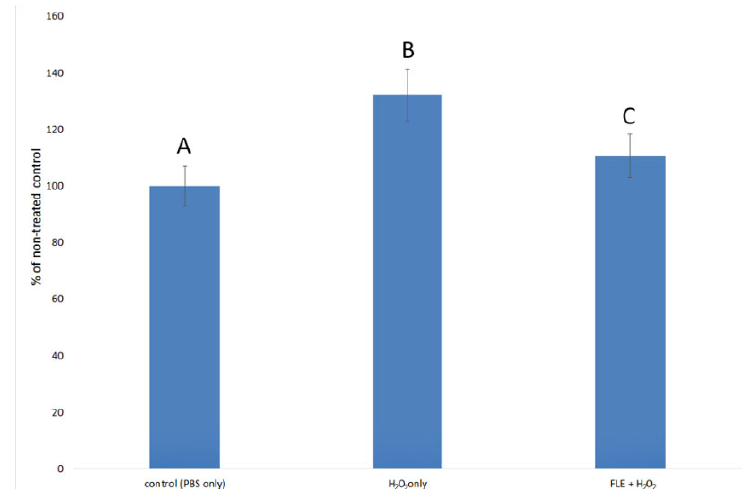
Figure 5. The expression of caspase-3, an early/moderate apoptosis marker, in HFFF-2 fibroblasts induced by hydrogen peroxide is shown as a percentage of control values (PBS only). H 2 O 2 only—cells treated with H 2 O 2 without the use of an extract; FLE + H 2 O 2 —cells incubated with 100 µ g/mL F. limosus extract and 500 μ M hydrogen peroxide. Different letters mean that the values for the bars differ statistically ( p < 0.05).